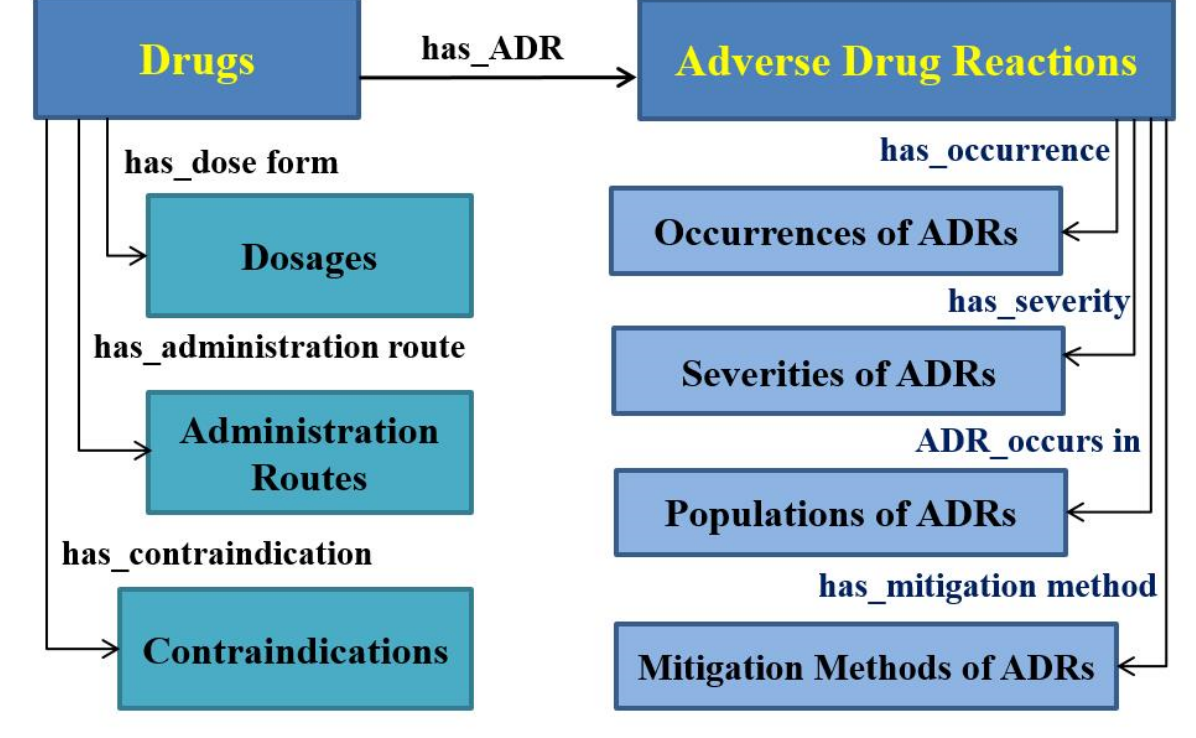
Figure 2. The generic model of ADRs ontology. ADRs: adverse drug